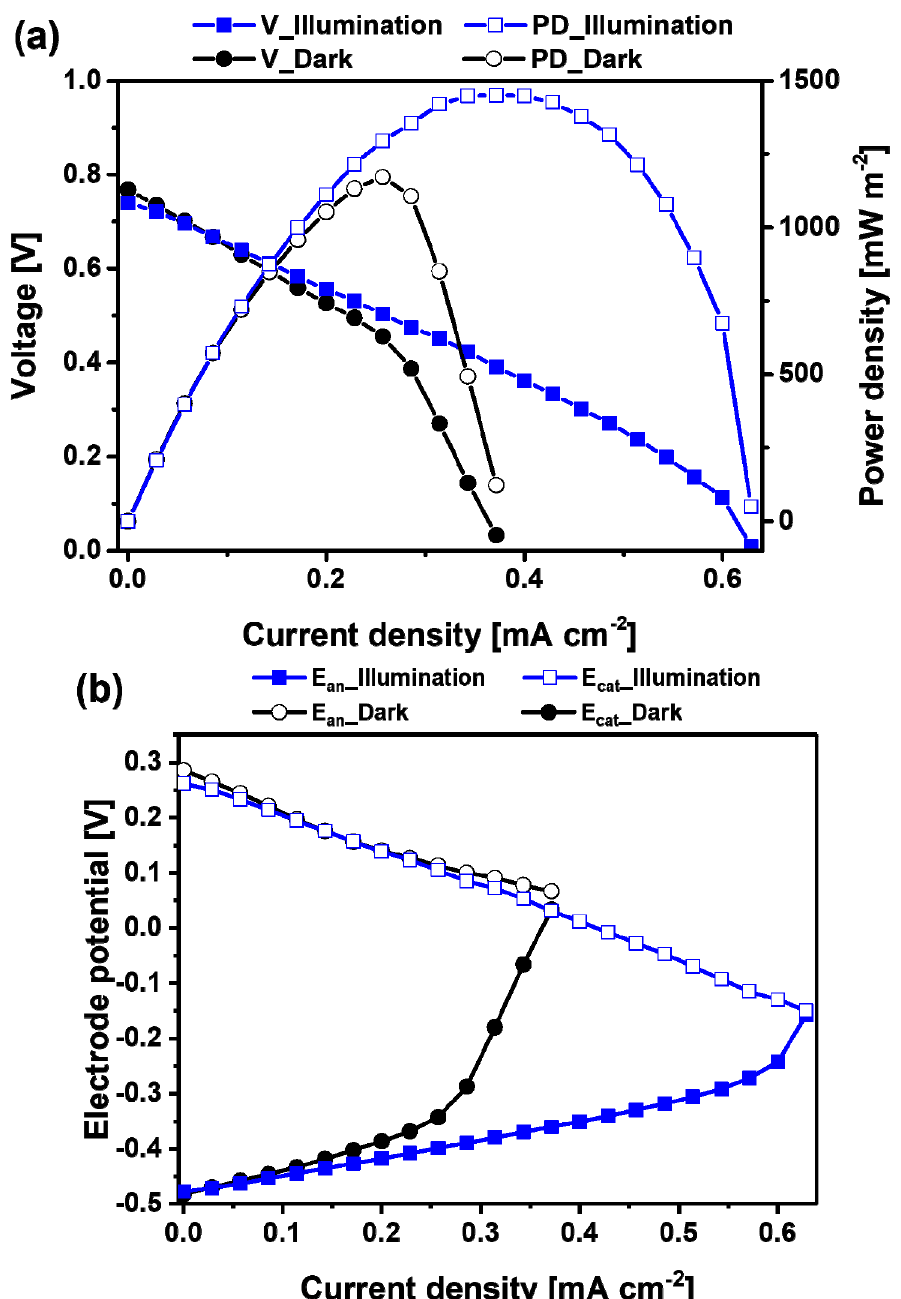
Figure 4. ( a ) Power density (open symbol), I–V polarization (solid symbol), and ( b ) electrode potential of hybrid MEC under simulated solar light and under dark (equal to a MEC without photoanode).